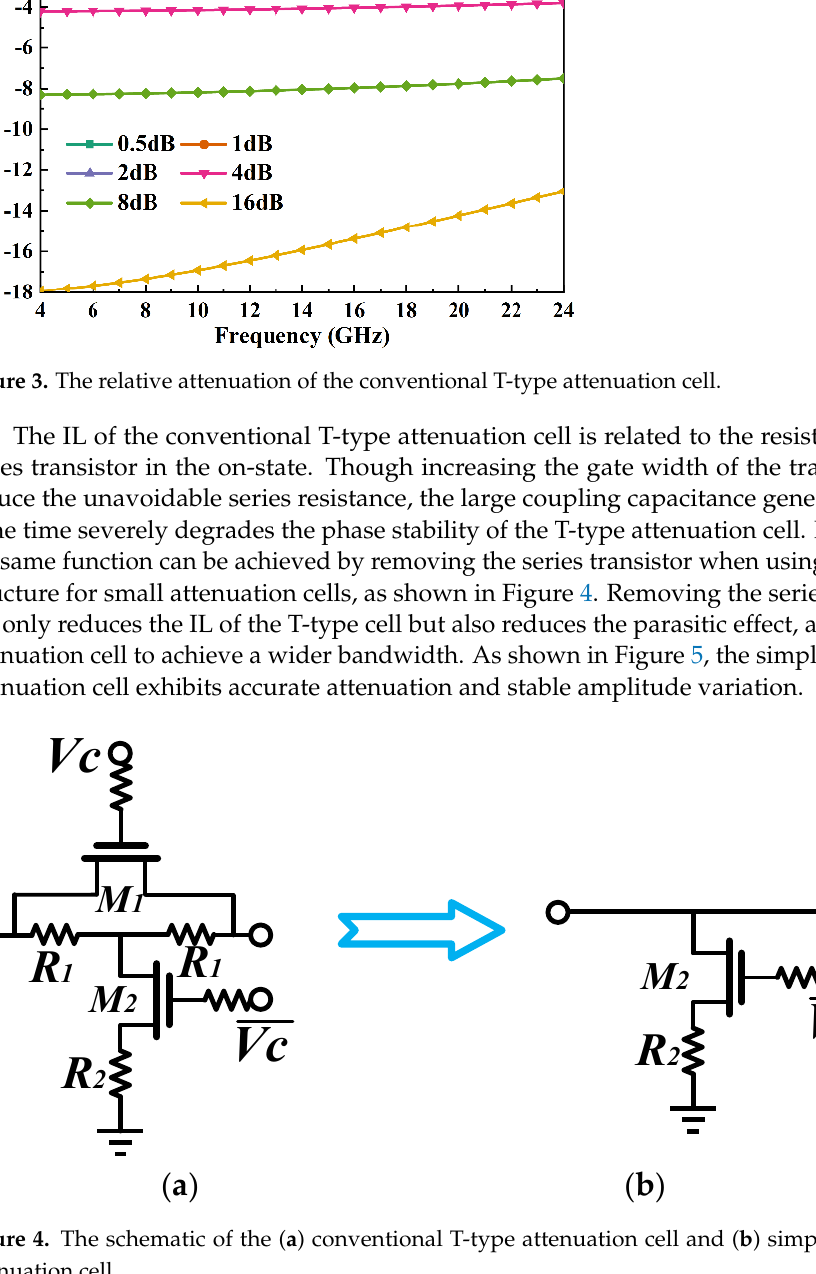
Figure 4. The schematic of the ( a ) conventional T-type attenuation cell and ( b ) simplified T-type attenuation cell.